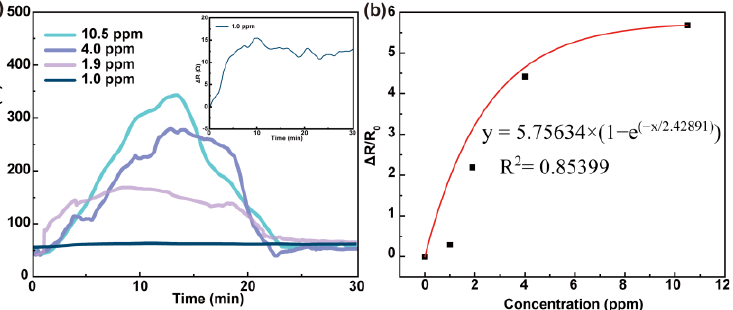
Figure 4. ( a ) Resistance–time curves of PEDOT:PSS-ATO/PEDOT films in response to different concentrations of HPV (inset: an enlarged version of the curve for 1.0 ppm). ( b ) Resistance response–HPV concentration fitting curve of PEDOT:PSS-ATO/PEDOT films. Table 1. Resistance response data of PEDOT:PSS, PEDOT:PSS/PEDOT, PEDOT:PSS-ATO, and PE- DOT:PSS-ATO/PEDOT films under different concentrations of HPV.